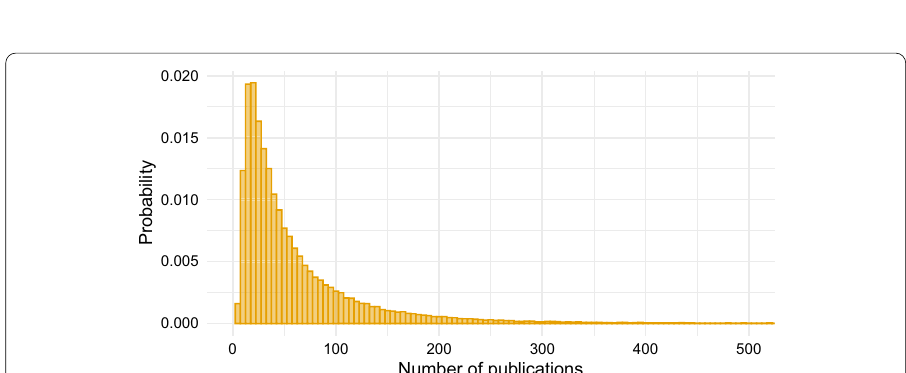
Fig. 5 Productivity distribution. The average number of papers published by the authors in our dataset is 65.7